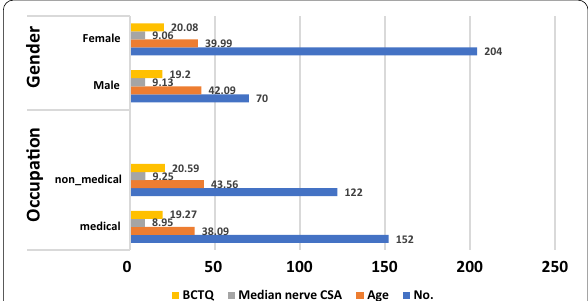
Fig. 2 Comparison between medical versus non-medical and male versus female participants regarding number, age, median nerve CSA and BCTQ